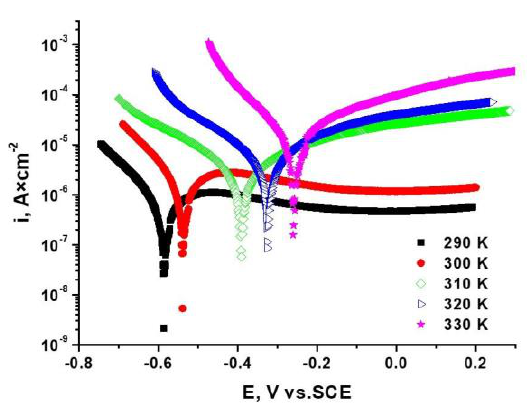
Figure 5. Polarization curves for NiCr alloy at different temperatures of artificial saliva.